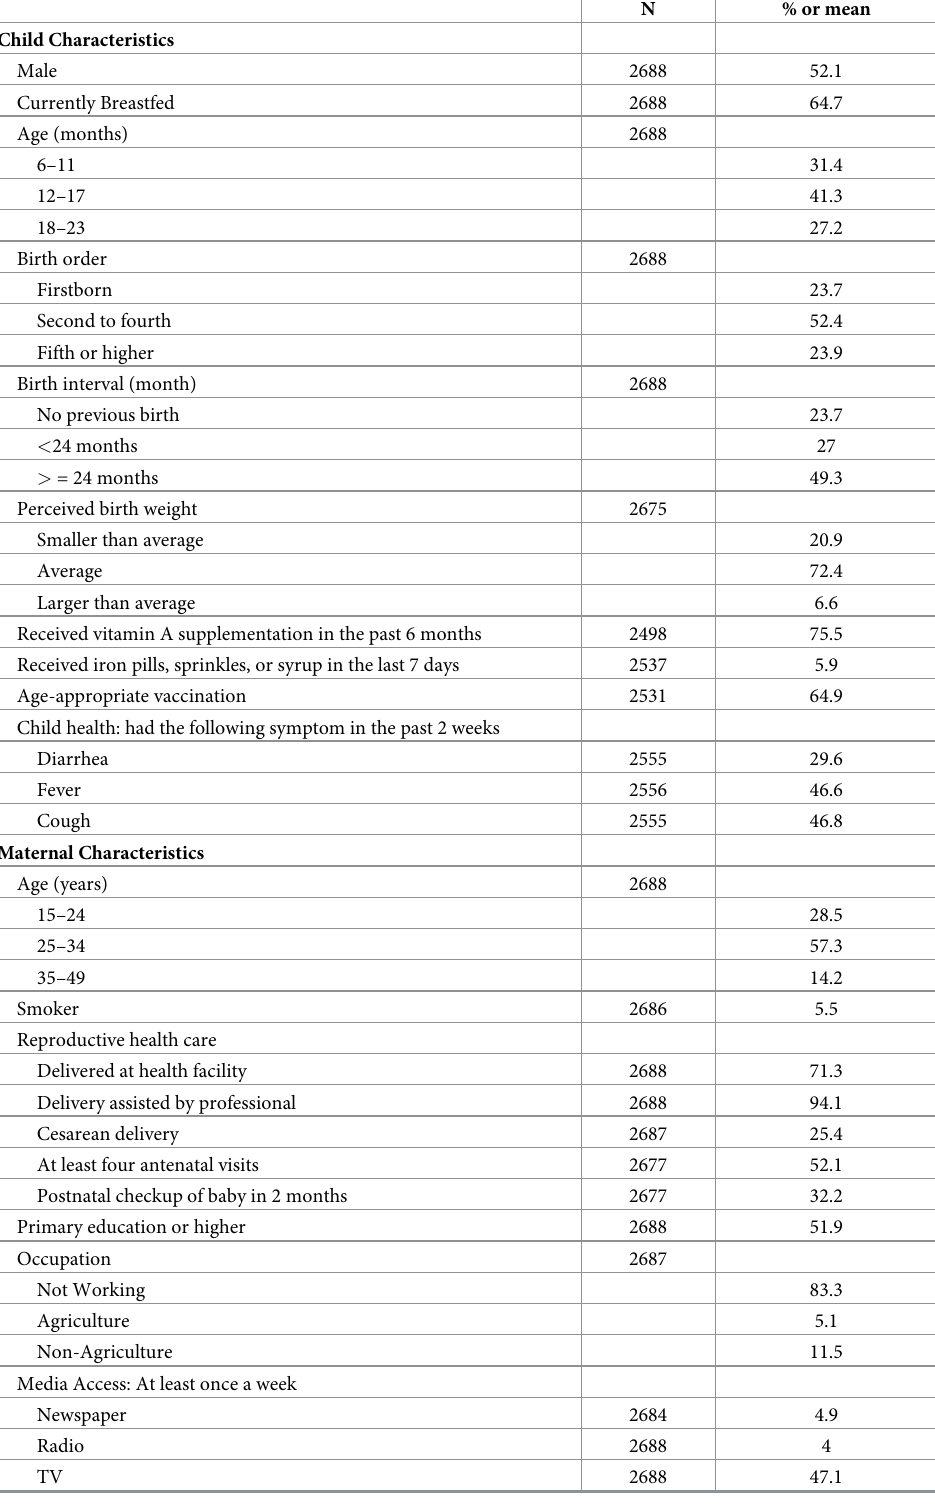
Table 1. Individual, household and community level characteristics of the study sample, Pakistan